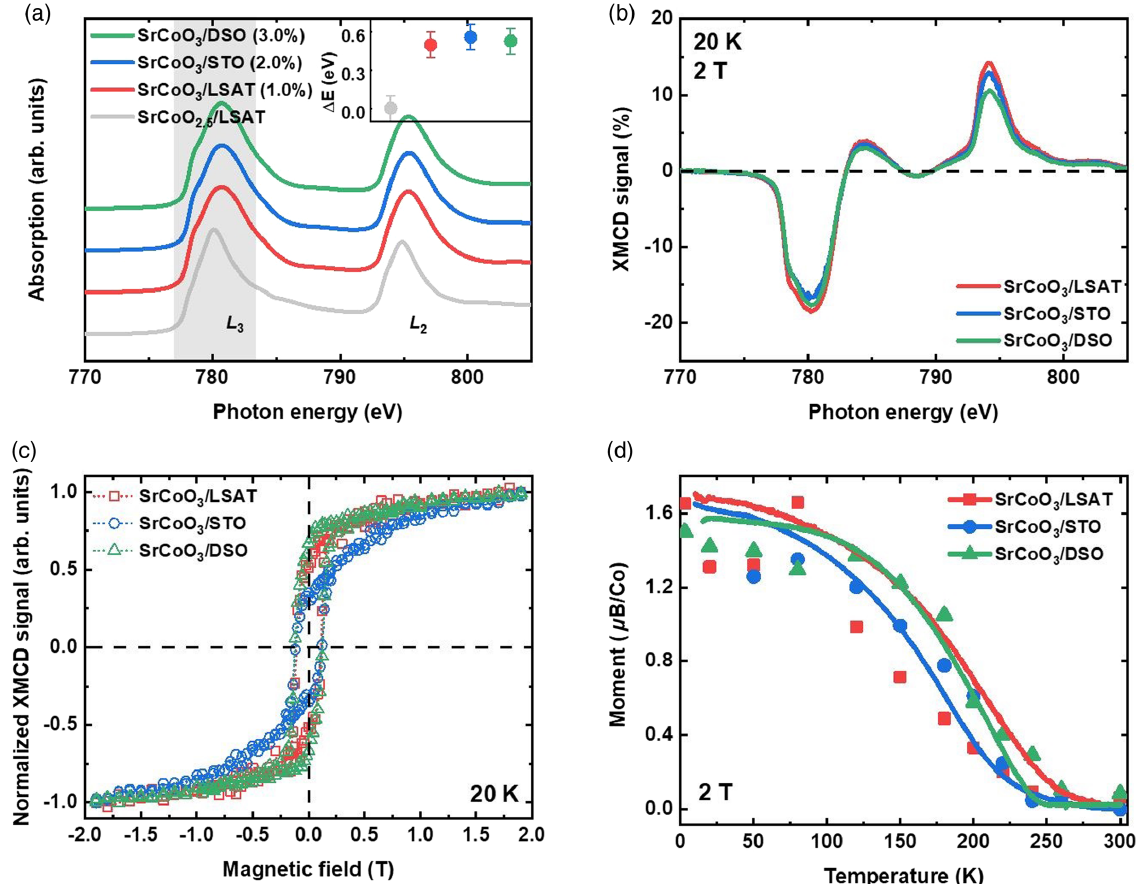
FIG. 2. Robust ferromagnetism in strained SrCoO 3 thin films. (a) Comparison of the Co L -edge x-ray absorption spectra taken using the fluorescence yield mode. The inset shows negligible peak shift (within the resolution of 0.1 eV) at the Co L 3 edge for all SrCoO 3 samples. (b) Co L -edge XMCD spectra taken from strain engineered SrCoO 3 thin films at 2 T and 20 K. (c) Magnetic-field-dependent XMCD signals for Co L 3 edge in strained SrCoO 3 thin films measured at 20 K. (d) Summary of the temperature-dependent magnetizations calculated by the XMCD sum rule (solid squares, circles, and triangles) and macroscopic magnetizations measured by SQUID (solid lines) (see Sec. IV) for SrCoO 3 thin films at various strain